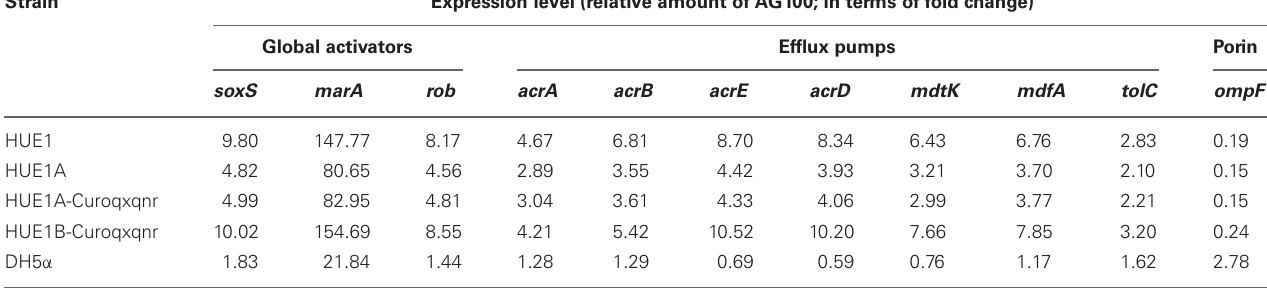
Table 4 | mRNA expression levels of global activators, efflux pumps, and ompF genes in HUE1, HUE1A, HUE1A-Curoqxqnr, and